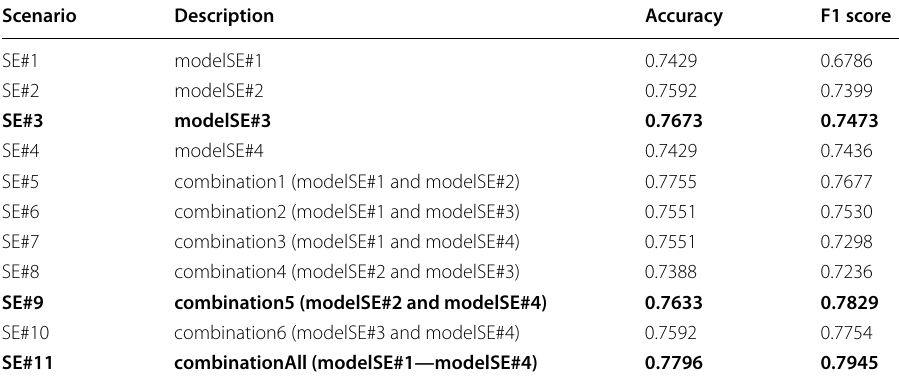
Table 7 BERTweet stacking ensemble (SE) result